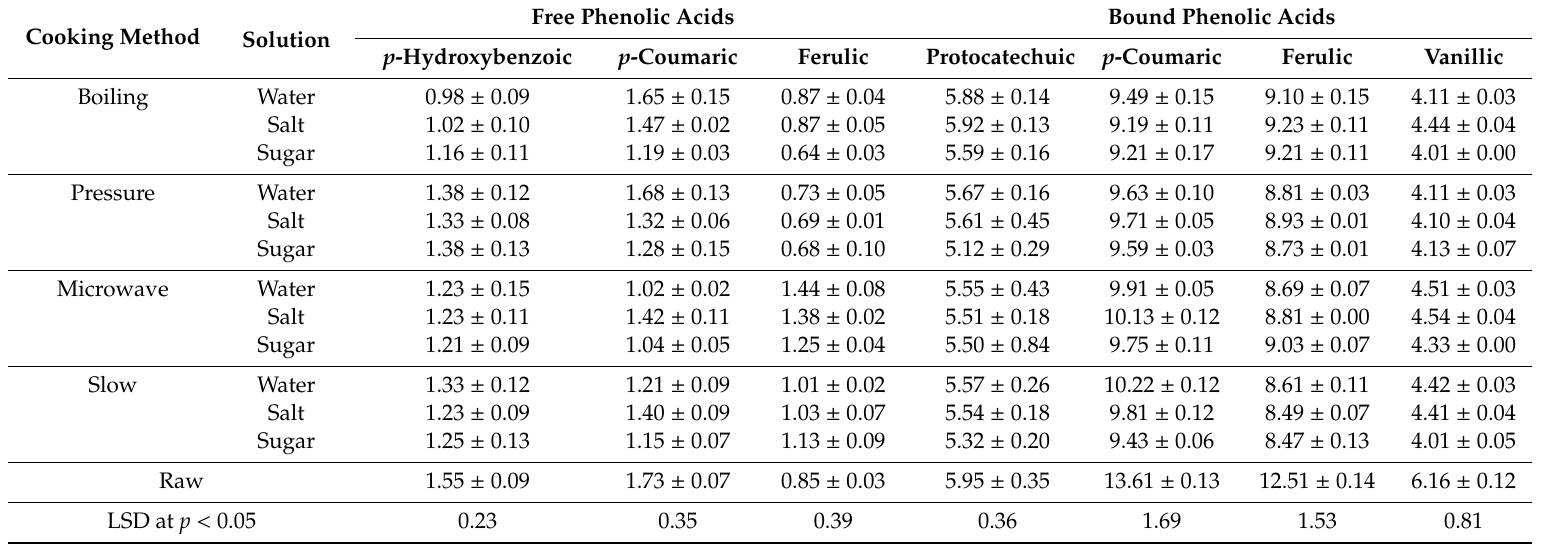
Table 2. E ff ect of four cooking methods on the composition of phenolic acids in lentils ( µ g / g, db). Cooking